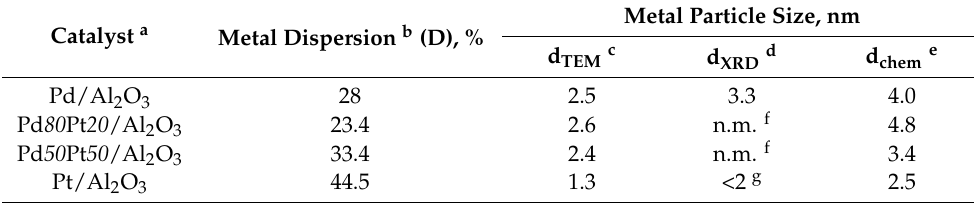
Table 1. Metal dispersions and metal particle sizes of alumina-supported Pd, Pt and Pd-Pt catalysts. Catalyst